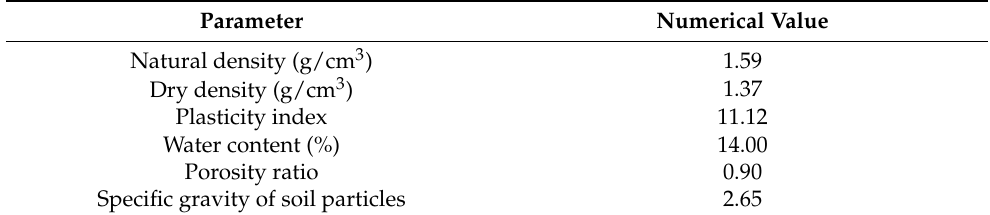
Table 1. Physical parameters of ionic RE ore.